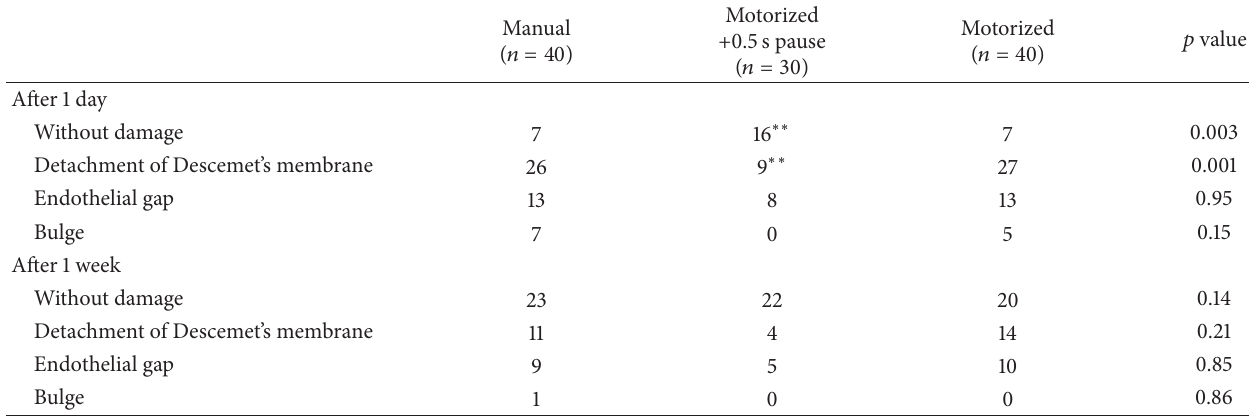
Table 3: Postoperative optical coherence tomography findings of the wound